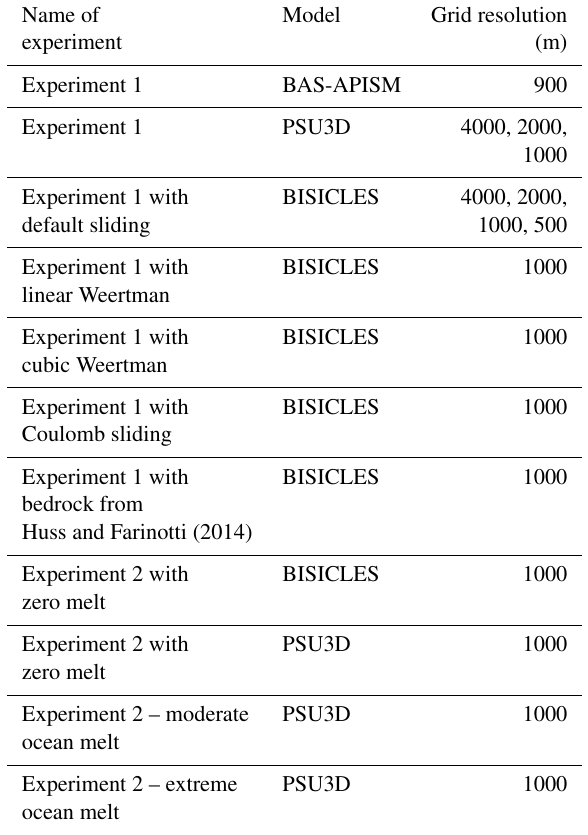
Table 1. Complete list of all perturbation experiments including sensitivity simulations as well as grid resolutions for experiments 1 and